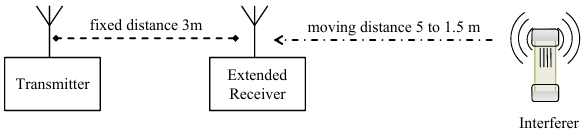
Figure 8. Measurement setup for moving